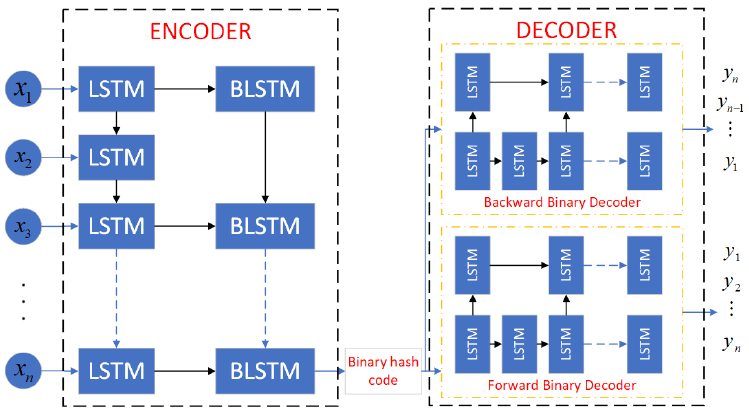
Figure 4. Binary